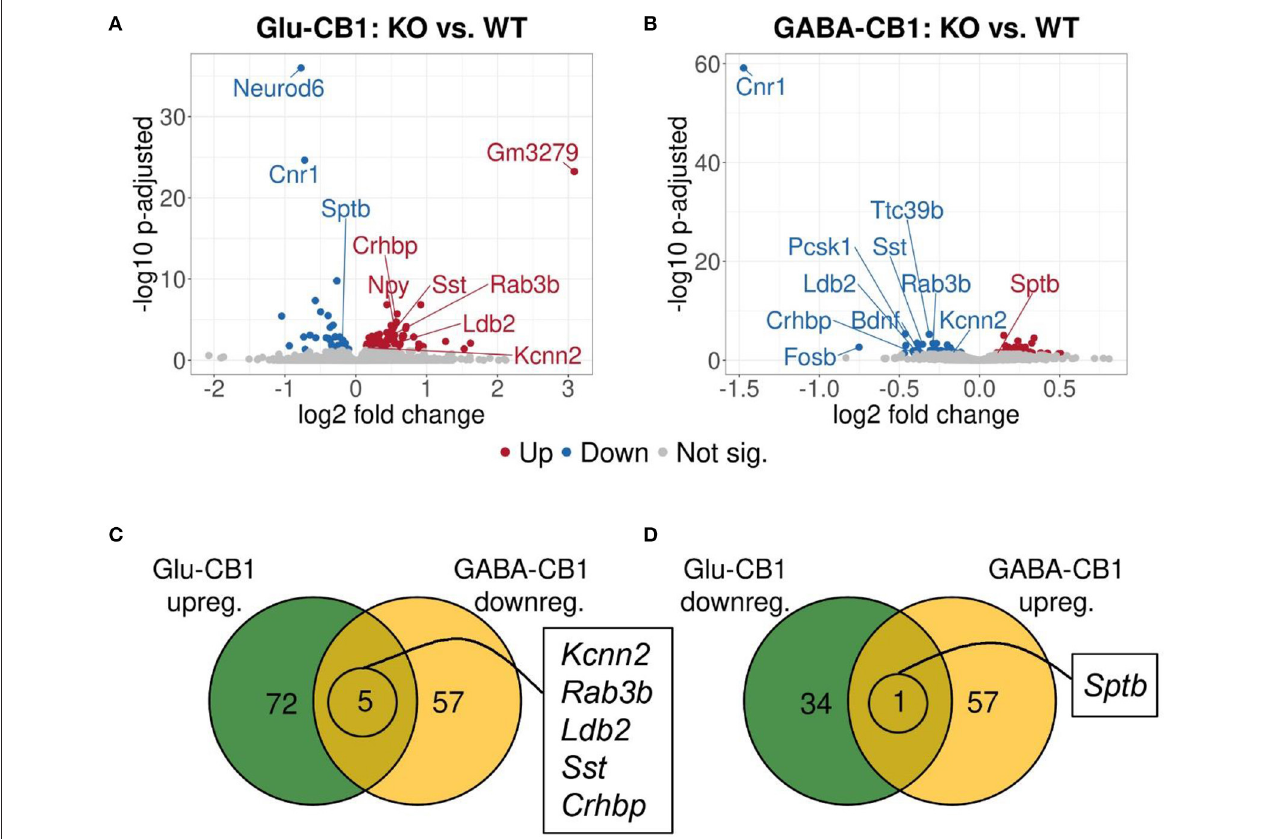
FIGURE 3 | Transcriptomic profiles from Glu-CB1-KO and GABA-CB1-KO mice after open field exposure. (A,B) Volcano plots showing differentially expressed genes (red and blue dots) found when comparing Glu-CB1-KO (A) and GABA-CB1-KO (B) mice to their respective CB1-WT after exposure to the open field arena. Red dots represent upregulated genes resulting from these comparisons, whereas blue dots indicate downregulated genes. Labels of the top3, dichotomic, and qPCR-validated DEGs are shown. Non-significant genes are colored in gray. (C,D) Venn diagrams to visualize the number of dichotomic genes found between Glu-CB1-KO and GABA-CB1-KO data after open field exposure, i.e., those genes that appear up-regulated in one of the conditional CB1-KO lines and down-regulated in the other, or vice